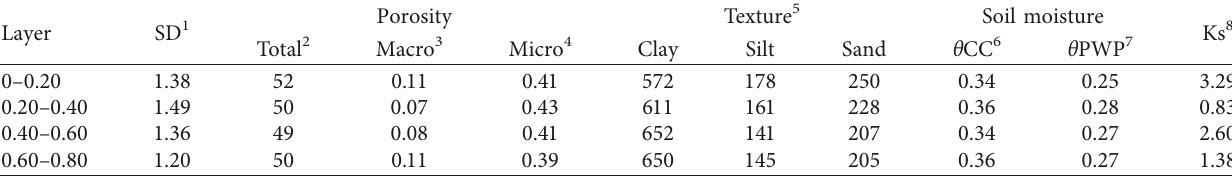
Table 1: Physical characterization of the soil from the experimental area in the layer 0–0.20m before conducting the experiment. Porosity Layer SD 1